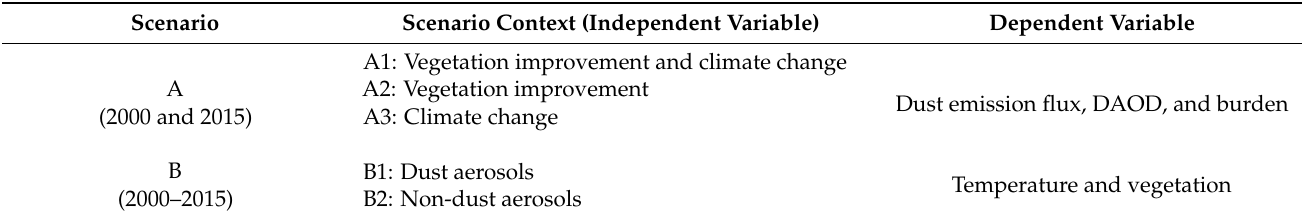
Table 2. Scenarios used in the RegCM